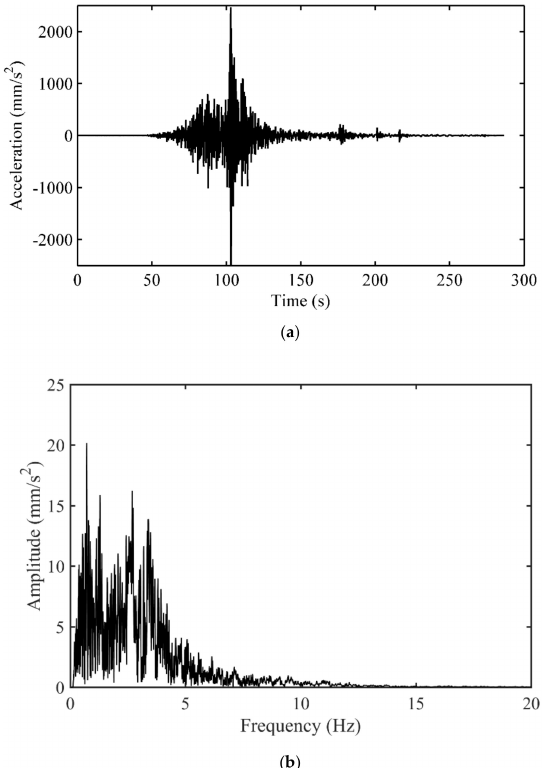
Figure 10. Recorded acceleration of Kaikoura earthquake: ( a ) Full time history; ( b ) Amplitude spectrum.